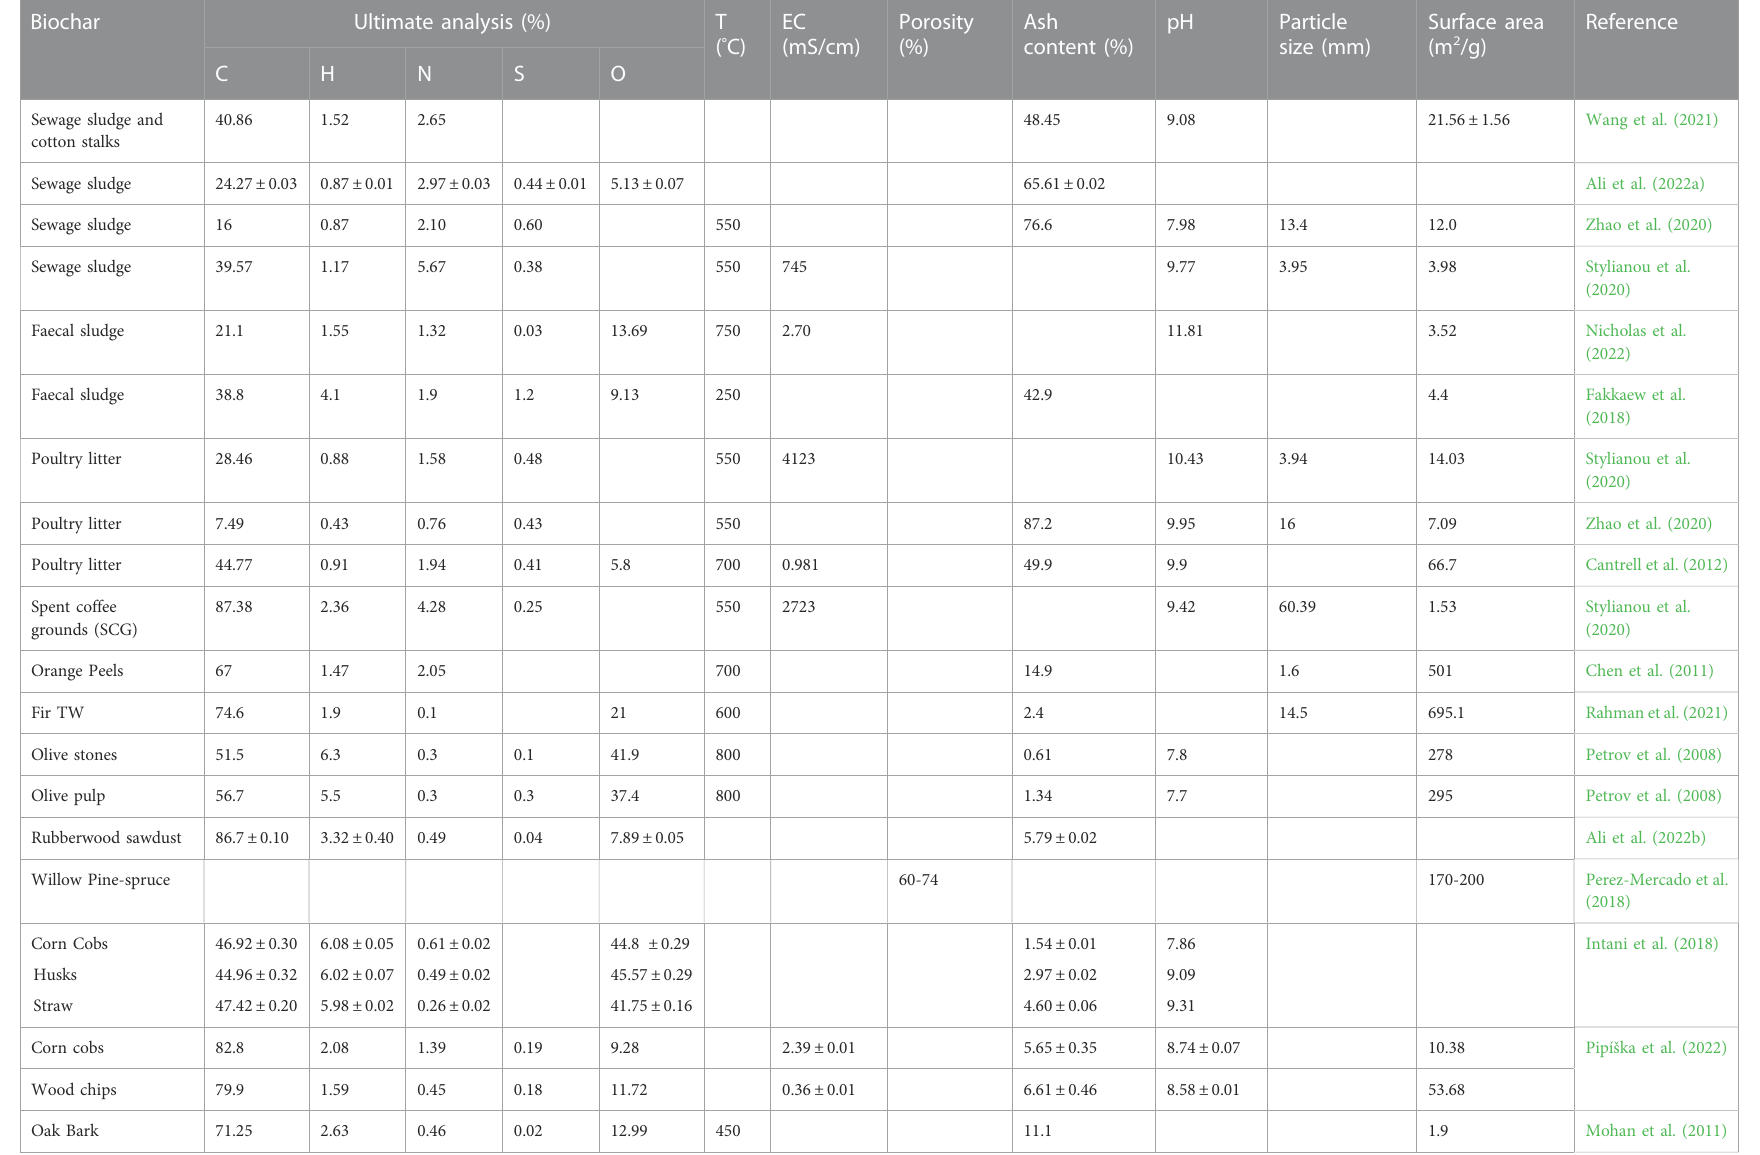
TABLE 4 Characteristics of biochar from various feedstock.